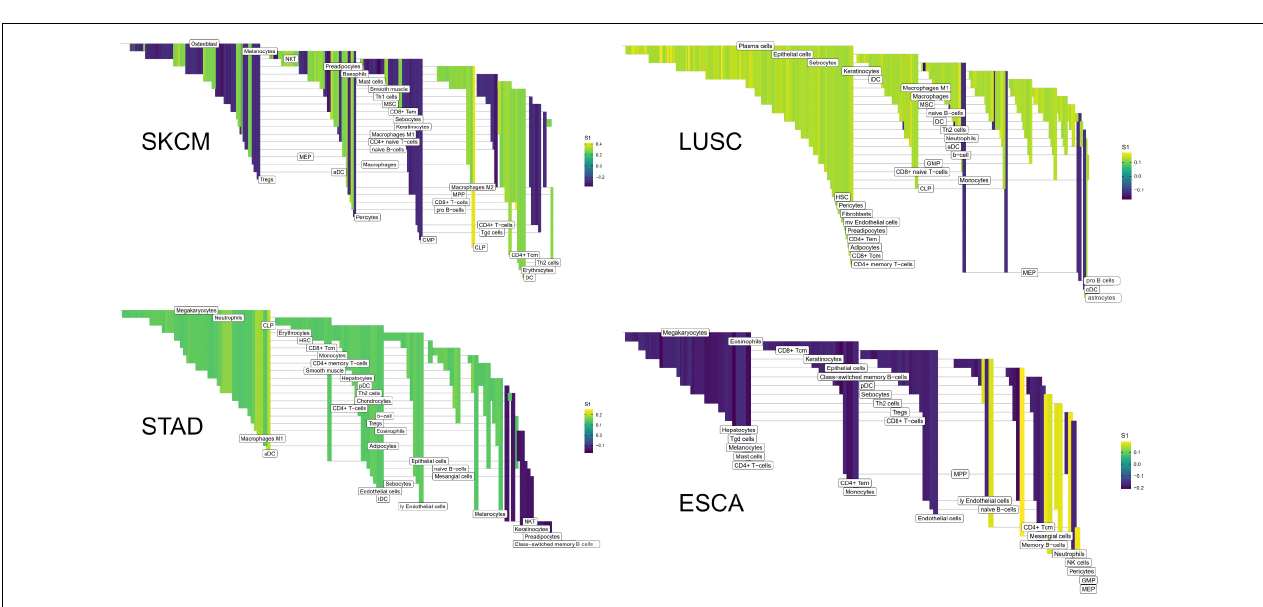
FIGURE 8 | High weight edges (DWEs) from PFI contrasts form predictive connected subnetworks. Color indicates the magnitude and direction of S 1 statistics ( ± ).